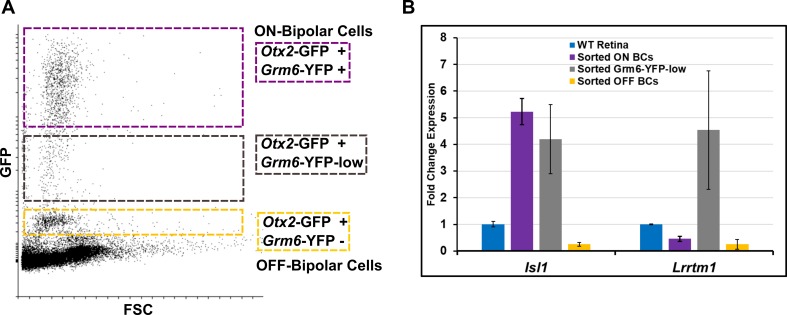
BC5D is likely excluded from both ON and OFF populations.(A) FACS scatterplot showing the range of GFP/YFP fluorescence in Otx2-GFP; Grm6-YFP mouse, as in Figure 1B. An additional population (YFP-low, boxed in gray) between the ON and OFF populations was collected for analysis by RT-qPCR. (B) RT-qPCR analysis as in Figure 1C in sorted ON, OFF, and YFP-low populations. The YFP-low population expresses the ON bipolar cell marker Isl1, and is enriched for Lrrtm1, a marker for ON bipolar cell type 5D.